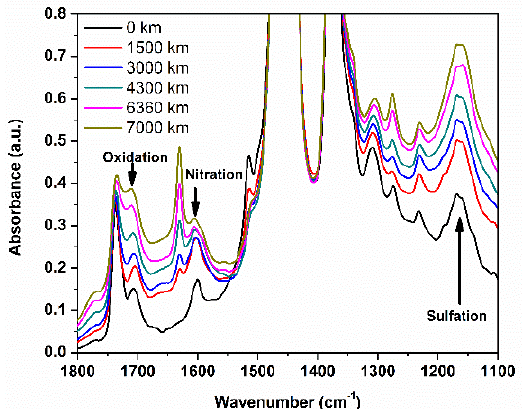
Figure 3. FT-IR spectra of all samples and identification of the vibrational bands used for the determination of oxidation, nitration, and sulfation levels.